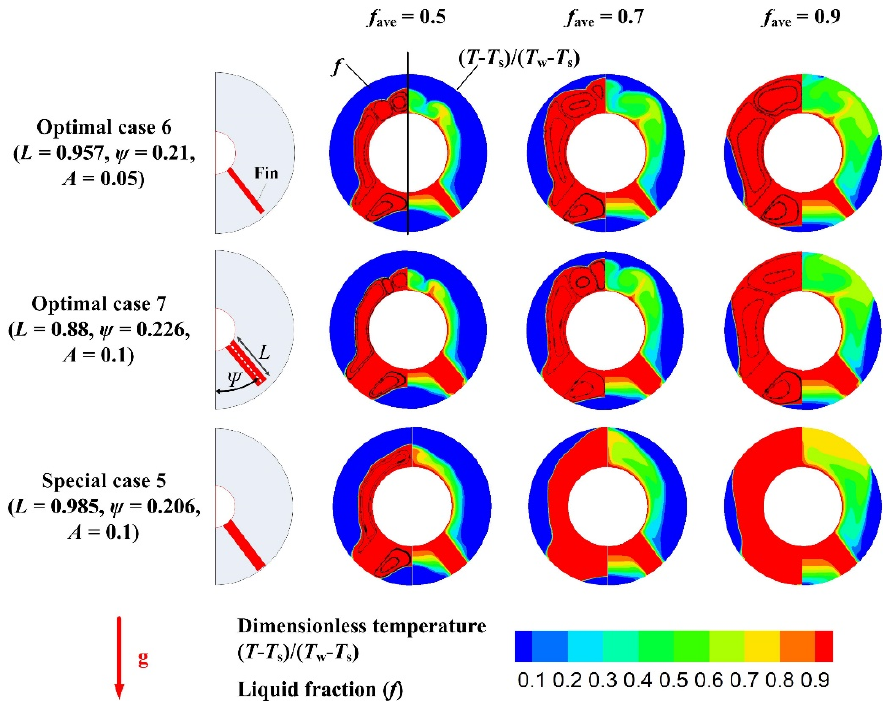
Figure 13. Contour maps of liquid fraction and dimensionless temperature for Optimal Cases 6 and 7 and Special Case 5.